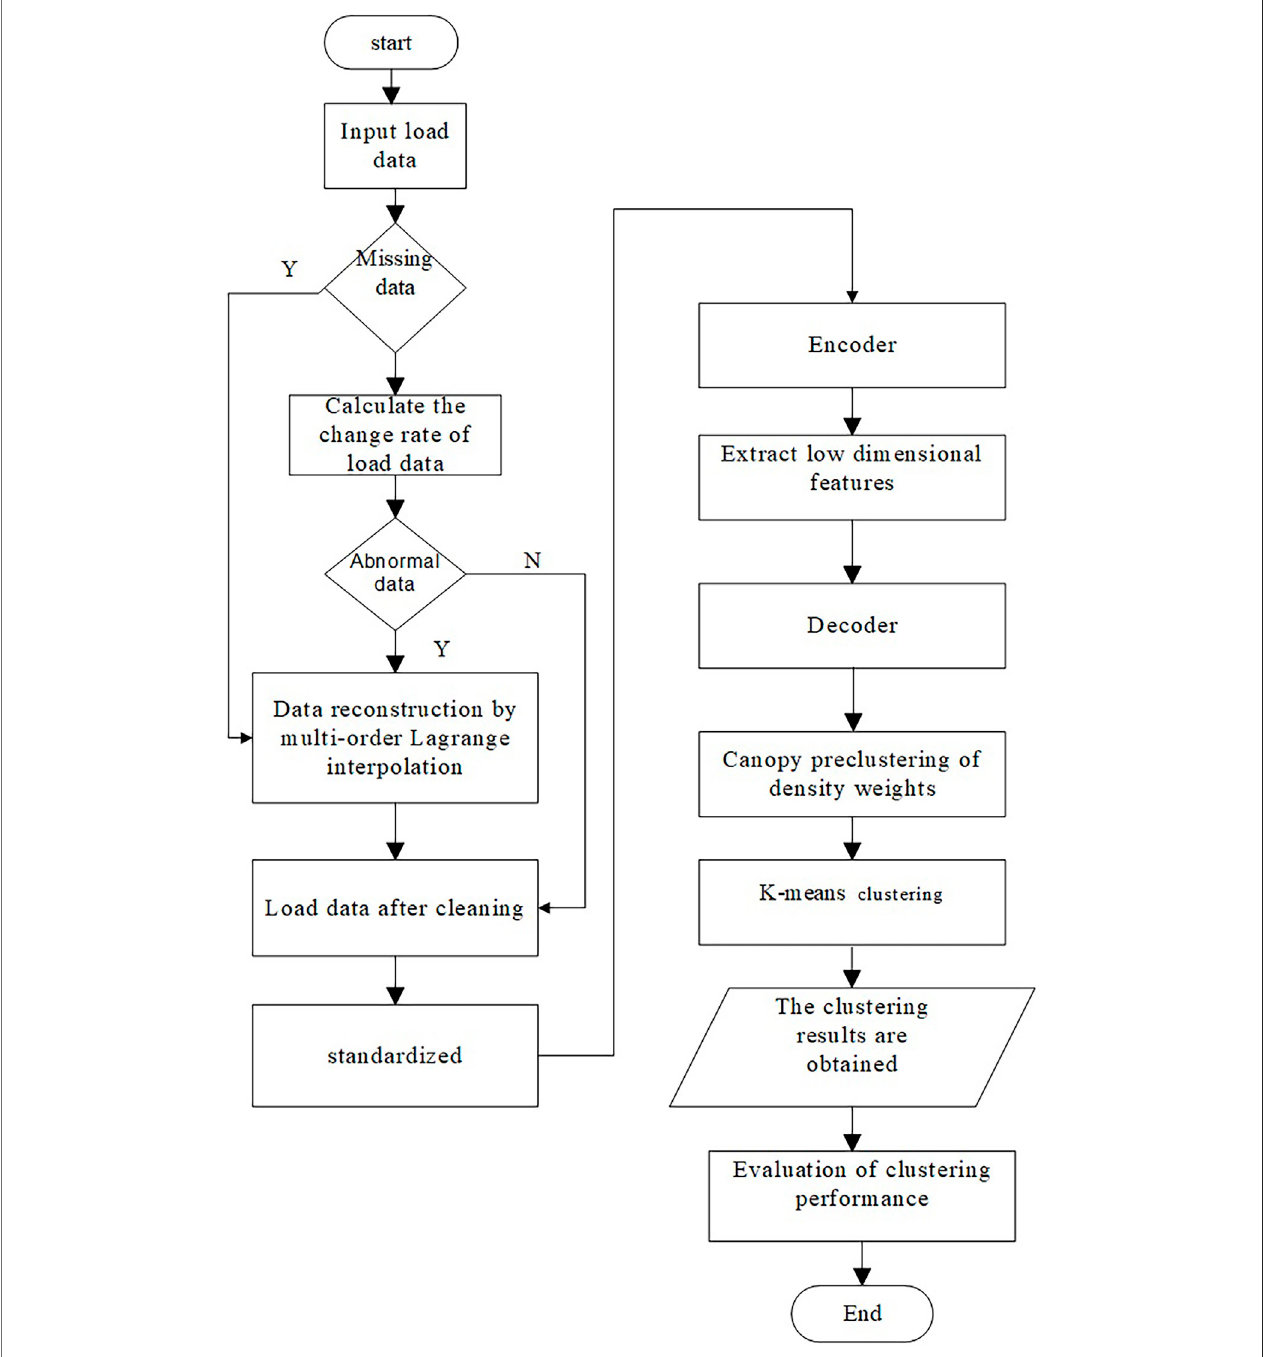
FIGURE 3 | Overall algorithm fl ow